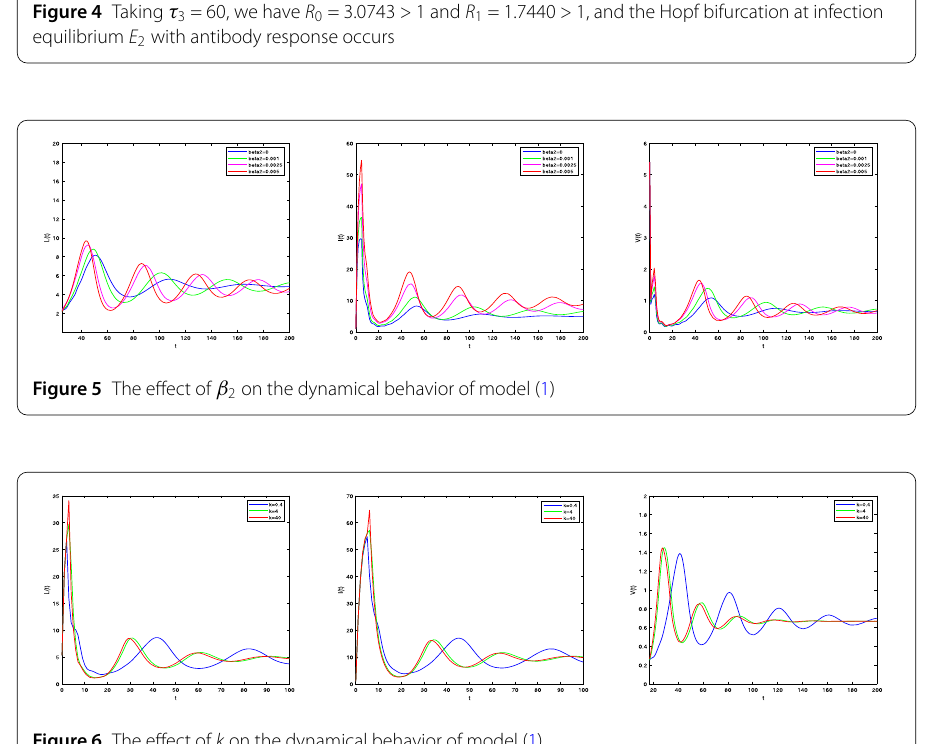
Figure 6 The effect of k on the dynamical behavior of model